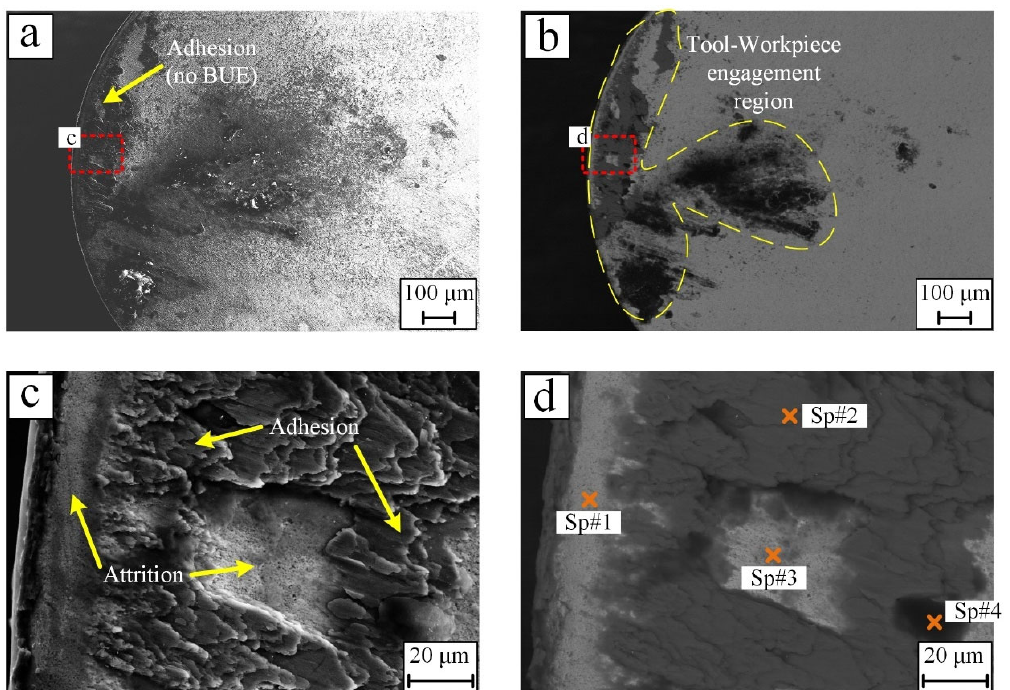
Figure 17. The worn inserts after machining wrought titanium tubes at a cutting depth of 0.25 mm: ( a ) secondary electron image showing the overview of the worn area, ( b ) backscatter electron image highlighting tool-workpiece contact area, ( c ) enlarged area of shown in ( a ), and ( d ) enlarged area shown in ( b ).